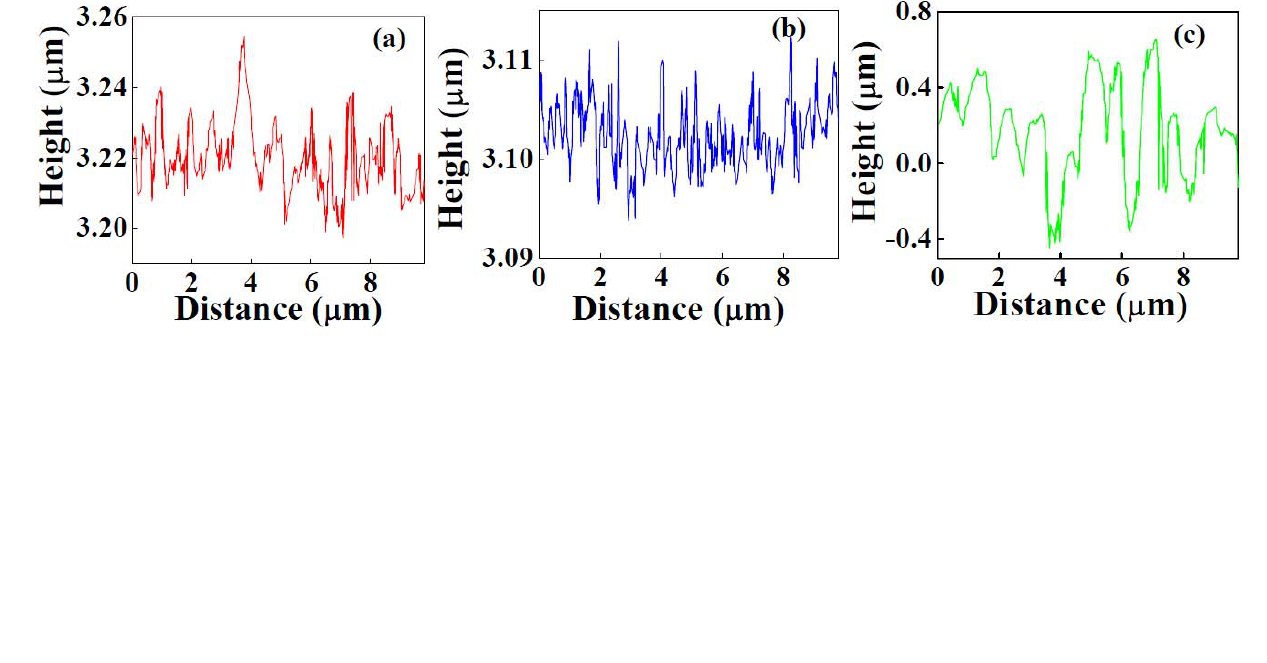
O coating, and ( c ) template assisted Y 2 3